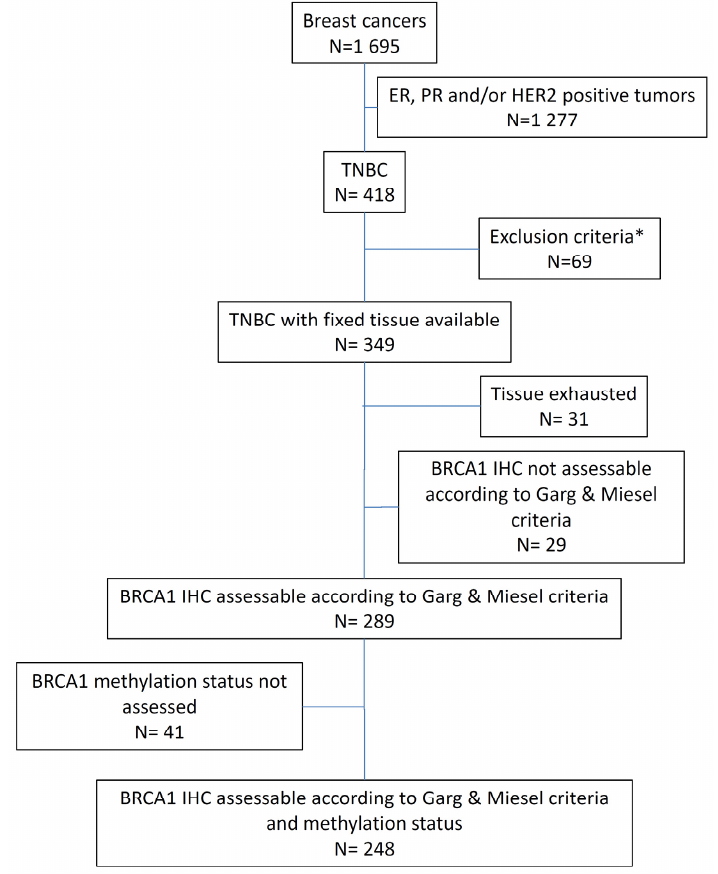
Figure 1. Consort diagram .